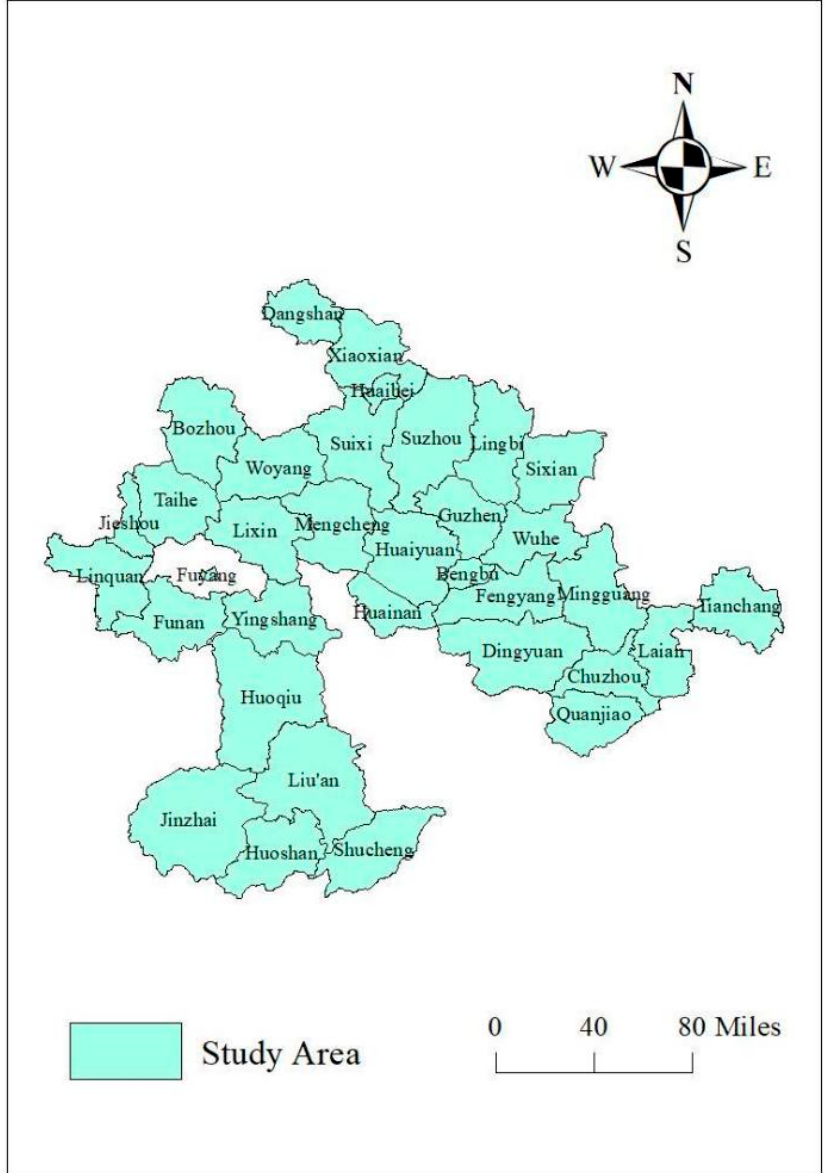
Figure 1. The location of the HREB.